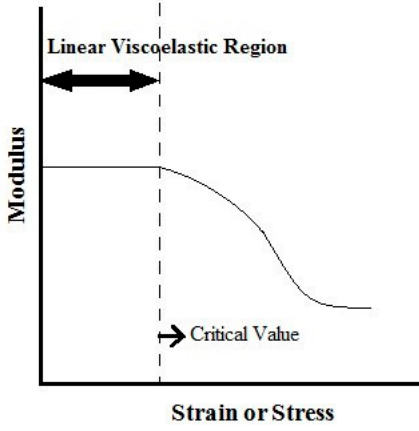
Figure 3. Schematic representation of the dependence of the dynamic (G ′ and G ″ ) moduli with the strain or stress and the critical value given by linear viscoelasticity limits.